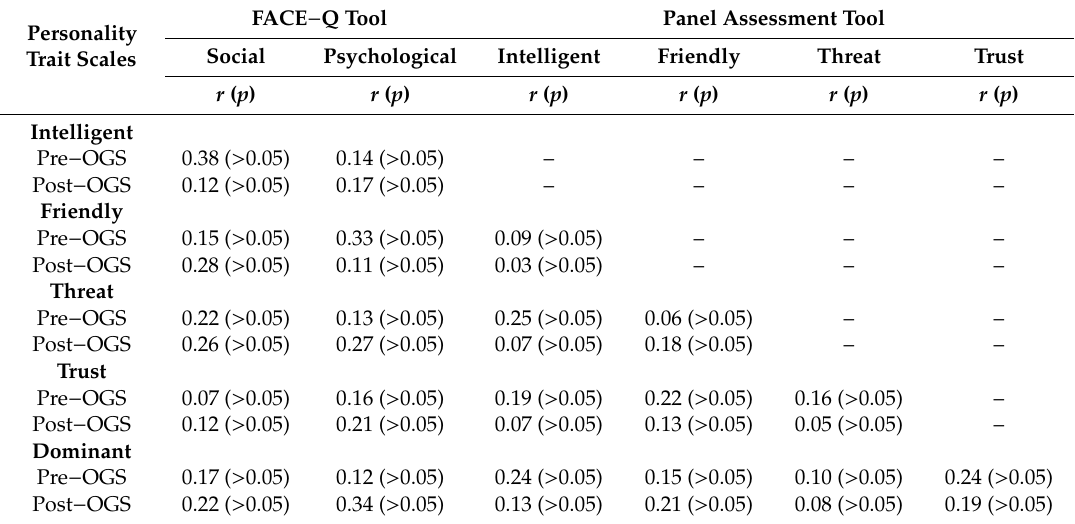
Table 7. Correlations for Pre − and Post − Orthognathic Surgery Assessment Scores of FACE − Q Quality of Life Scales and Orthodontist − Based Panel Assessment of Personality Trait Scales.